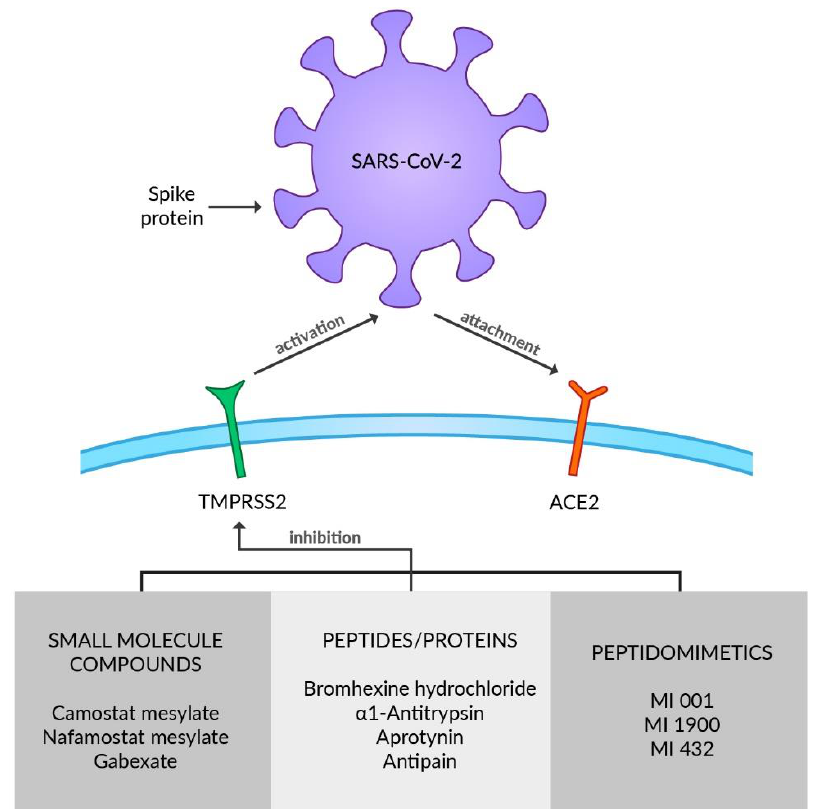
Figure 2. SARS-CoV-2 S protein cleavage by TMPRSS2 protease enables virus cell entry. Inhibition of TMPRSS2 activity is a promising therapeutic target in fighting SARS-CoV-2 infection.